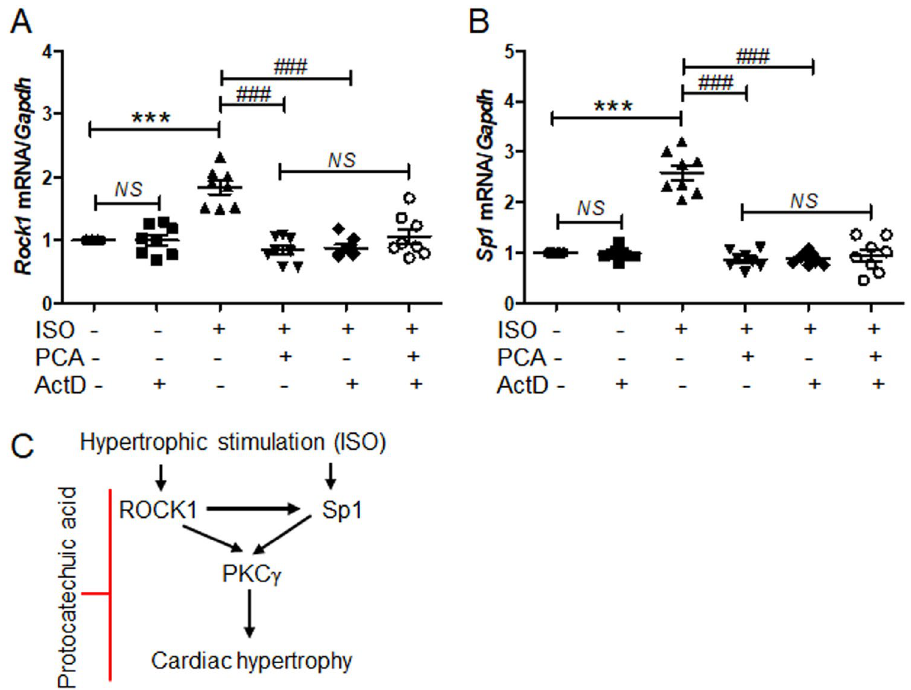
Figure 8. Protocatechuic acid does not regulate the expression of ROCK1 and Sp1 at the transcriptional level. ( A , B ) H9c2 cells were cultured with isoproterenol (10 μM) and then incubated with protocatechuic acid (10 μM) in the presence or absence of actinomycin D (2.5 μg/ml) for 6 h. The mRNA levels of Rock1 and Sp1 were quantified using RT-PCR and normalized to Gapdh . Data are presented as the mean ± S.E. Statistical analysis: one-way ANOVA followed by Bonferroni post hoc tests. ***P < 0.001; ### P < 0.001; NS, not significant. Graphs were prepared using GraphPad 5.0. ( C ) Schematic diagram of proposed mechanisms involved in isoproterenol-induced cardiac hypertrophy. Isoproterenol increases the expression of ROCK1, Sp1, and PKCγ. Sp1 increases the size of cardiomyocytes and induces PKCγ expression. Our results suggest that PKCγ is a downstream target of ROCK1 and Sp1. Protocatechuic acid treatment suppresses isoproterenol-induced cardiac hypertrophy via the downregulation of ROCK1–Sp1–PKCγ